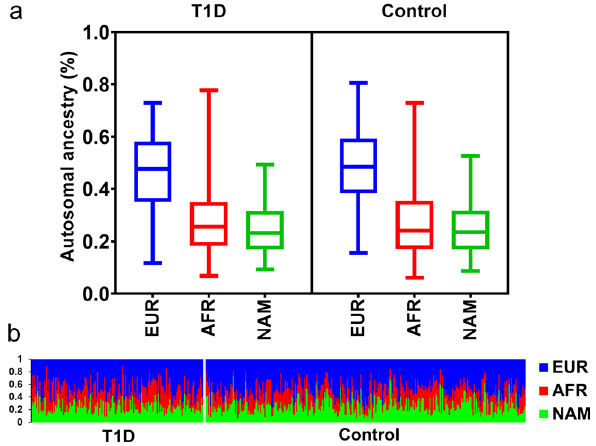
Figure 1. Box plot ( a ) and individual ( b ) proportions of the ancestry estimates for the patients with T1D and control group, using 46 AIM-Indel. EUR European. AFR African. NAM Native American. Ancestry estimates were obtained using STRU CTU RE, for the following options: k = 3; 50,000 burning steps, followed by 50,000 Markov Chain Monte Carlo iterations; Admixture model (Use population Information to test for migrants); and allele frequencies were correlated and updated using only individuals with POPFLAG = 1.